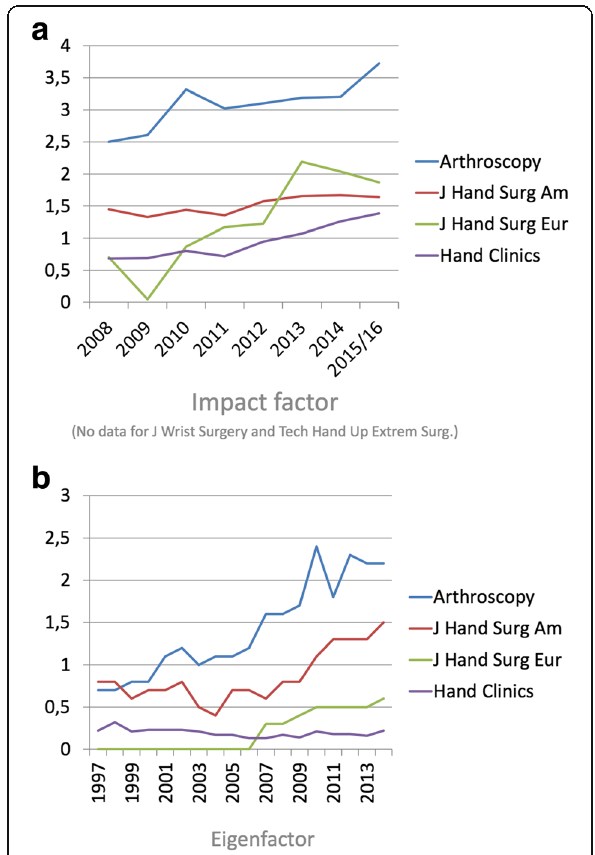
Fig. 5 a and b . The Impact factor and Eigenfactor for the most common journals. No data were available for Tech Hand Up Extrem Surg and J Wrist